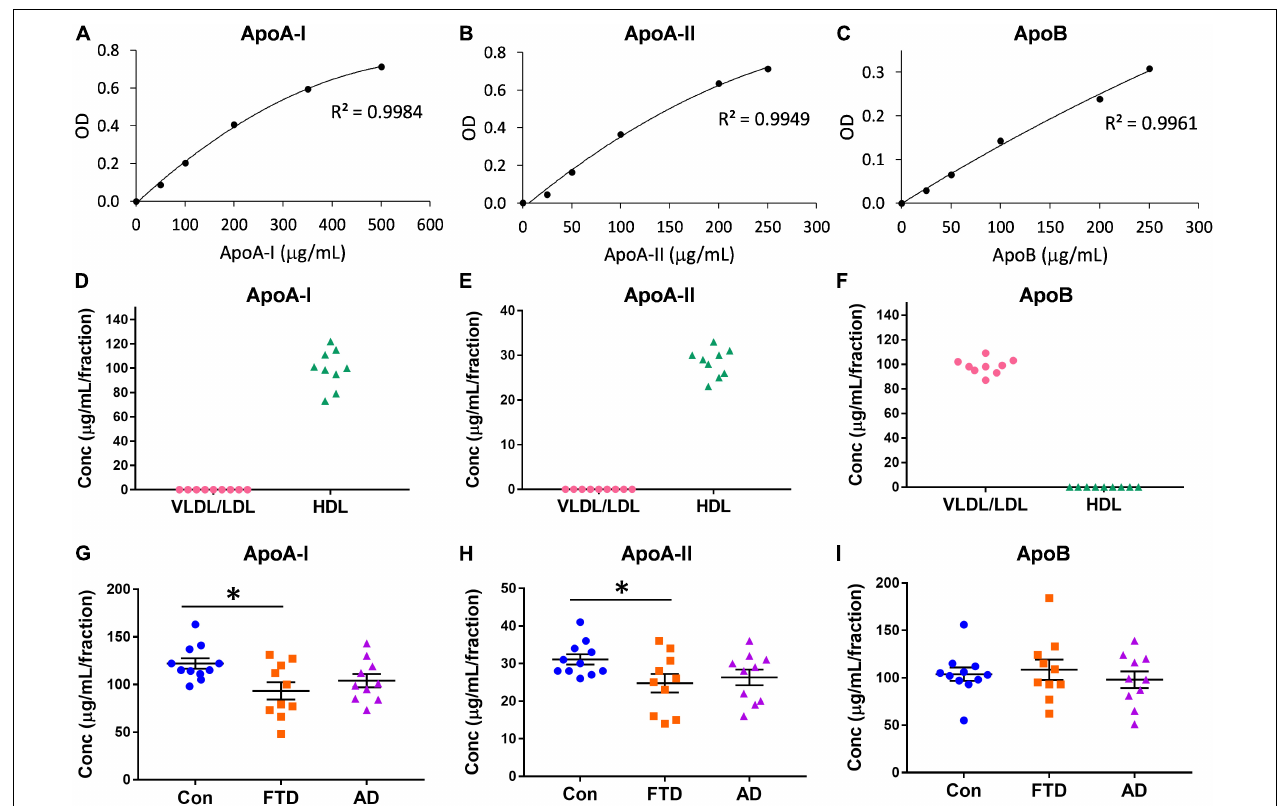
FIGURE 2 | Apolipoprotein levels in lipoproteins in bvFTD, AD, and controls. (A–C) Apolipoprotein assay standard curves with R 2 value. (D–F) Confirmation that apoA-I and apoA-II are present only in HDLs and apoB is present only in VLDLs/LDLs. (G–I) Concentrations of apolipoproteins in bvFTD, AD, and controls. Bars represent mean and SE, ∗ p <